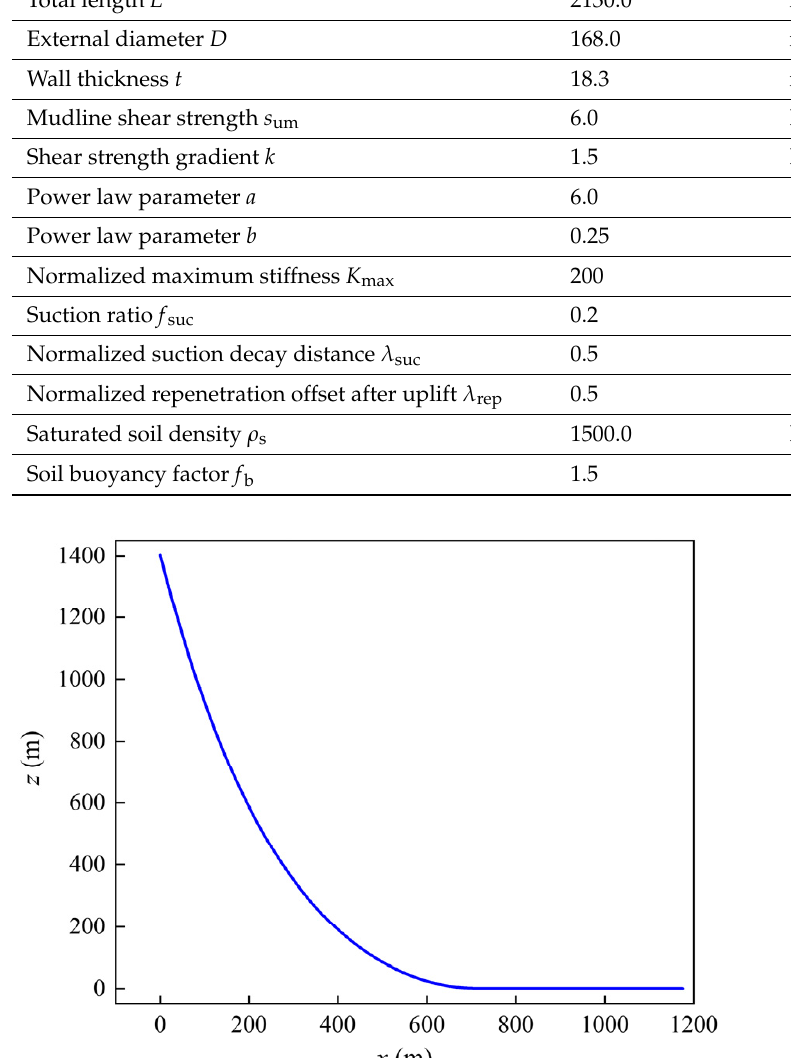
Figure 15. Static configuration of in situ SCR.